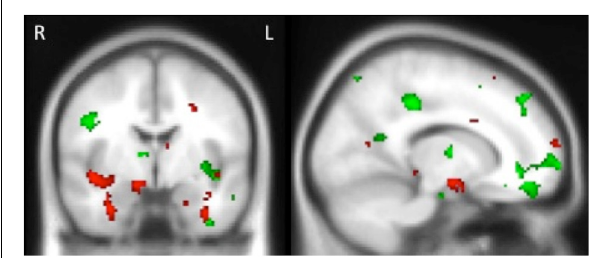
FIGURE 4 | Voxel-based morphometry results showing regions that correlate with memory performance (green) and emotional enhancement of memory (red) in all participants combined. Colored voxels show regions that were significant in the analyses p < 0 . 005 uncorrected for multiple comparisons. Clusters are overlaid on the standard Montreal Neurological Institute (MNI) brain. MNI Coordinates: x = 14, y = − 4, z = −